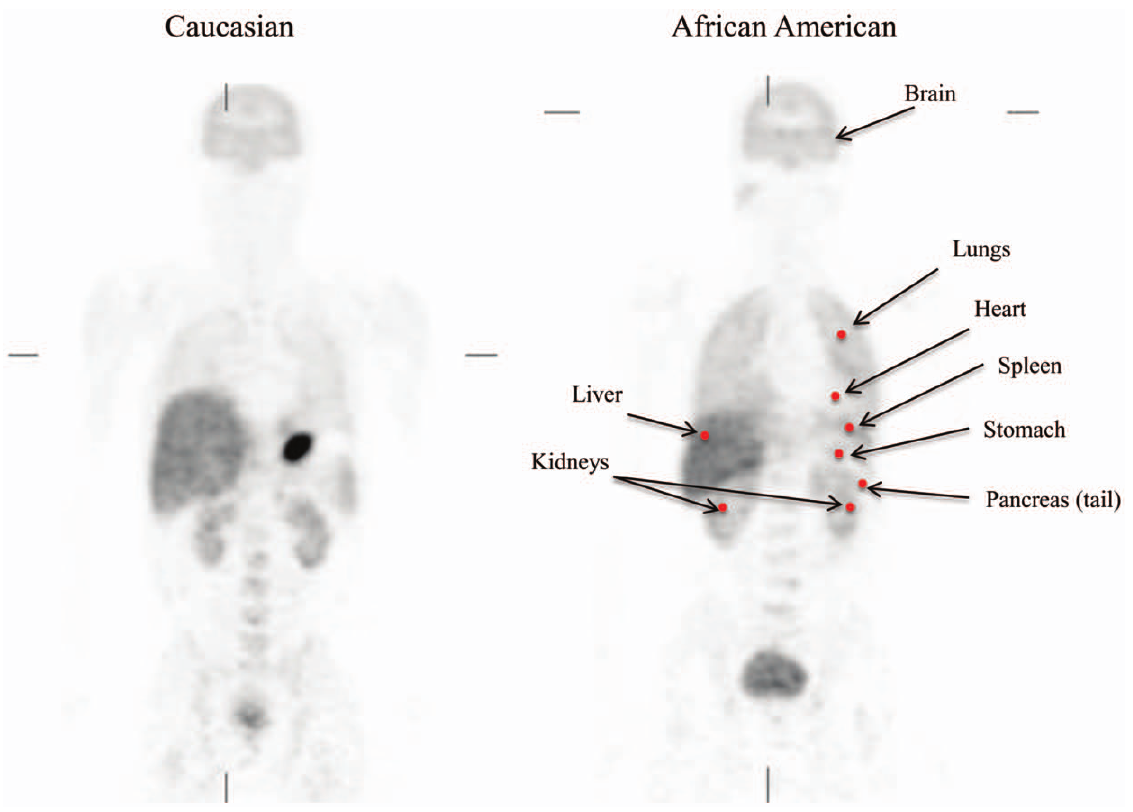
Figure 2. Whole body images of [ 11 C]d-methamphetamine in an African American (AA) and in a Caucasian (C) who received 7.18 and 6.99 mCi respectively and location of areas where ROI were obtained. Imaging was started 4 min post injection moving from head to pelvis in 12 minute segments. The images have been decay corrected. Note the higher accumulation of [ 11 C]d-methamphetamine in the lung of the AA than of the C. The hot spot on the abdominal cavity of the Caucasian corresponds to the stomach where [ 11 C]d-methamphetamine accumulation was high but quite variable across subjects (may reflect its acidic environment that favors trapping of methamphetamine, which is a weak base).